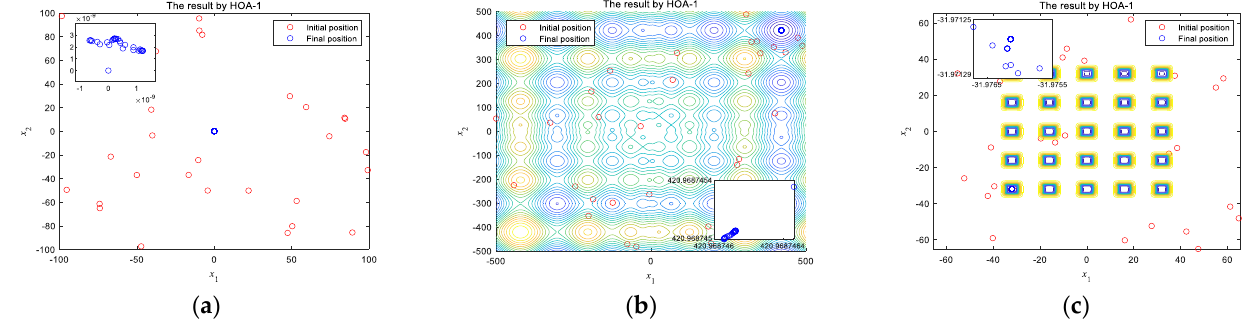
Figure 6. Initial and final positions of B-particles solved by HOA-1 for ( a ) F1; ( b ) F8; ( c ) F14.